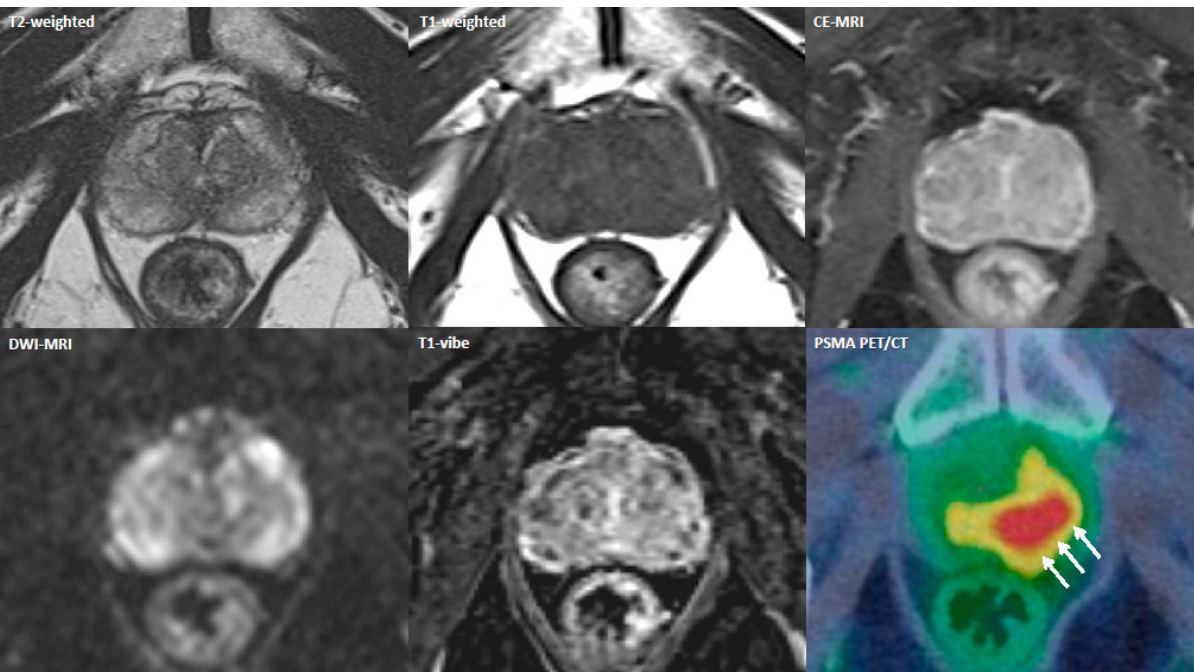
Figure 2. Multipanel comparison between mpMRI (PI-RADS 3) and [ 68 Ga]PSMA PET/CT (SUVmax 4.3; SUVratio to background 2.1) in a biopsy-naïve patient with PSA of 5.54 ng/mL. The highlighted lesion resulted in a GS 3+4 adenocarcinoma of the left prostatic lobe (white arrows). PSMA = prostate-specific membrane antigen; PET/CT = positron emission tomography/computed tomography; CE − MRI = contrast − enhanced MRI; DWI − MRI = diffusion − weighted imaging MRI.